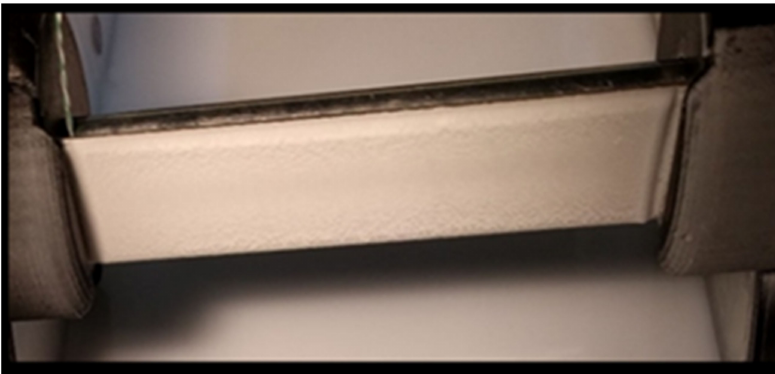
Figure 15. Image of rime ice obtained in the IWT on flat sample